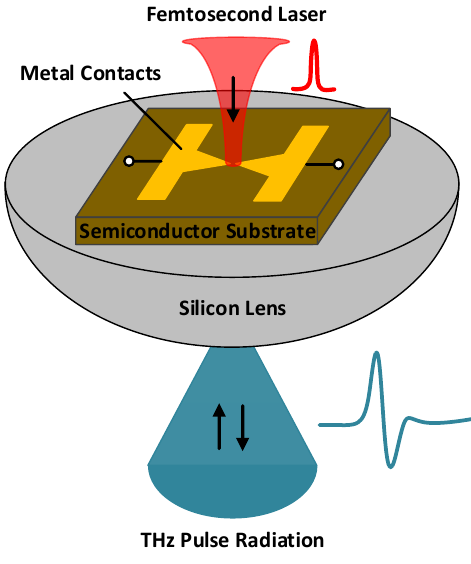
Figure 1. A conventional THz photoconductive antenna (PCA)